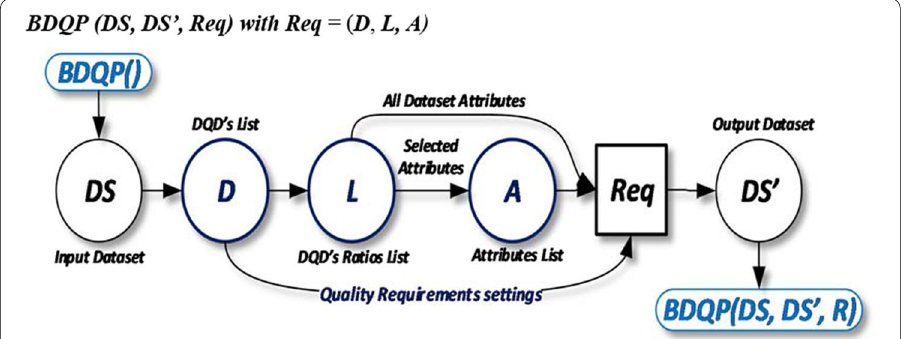
Fig. 6 BDQP and quality requirements